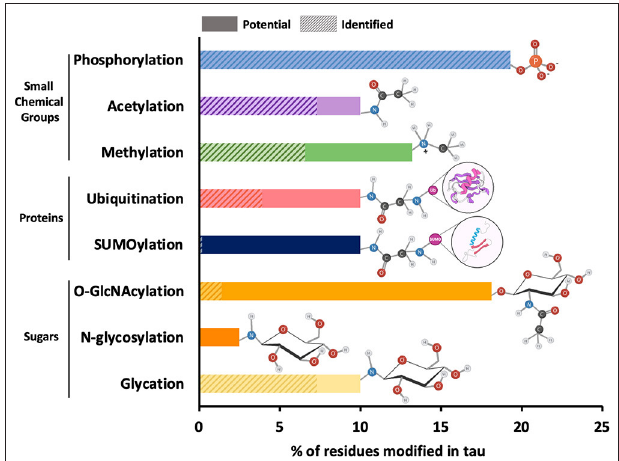
FIGURE 2 | Relative frequency of post-translational modifications on tau. The 2N4R isoform of tau contains 441 amino acid residues, around 35 percent of which can potentially undergo PTMs. These residues include serine (forty-five), threonine (thirty-five), tyrosine (five), asparagine (three), arginine (fourteen), and lysine (forty-four). The most common PTMs in tau are shown on the y-axis of the bar plot. The x-axis of the plot shows the percentage of amino acid residues with solid bars showing the sites that have been identified within total potential sites shown in shaded bars. The functional groups associated with each PTM are also shown next to each bar. Since all potential phosphorylation sites have been identified, the shaded bar is completely masked by the solid bar. Similarly, in case of N-glycosylation, the specific N-glycosylation sites have not been reported and therefore, only potential sites represented by shaded bar have been